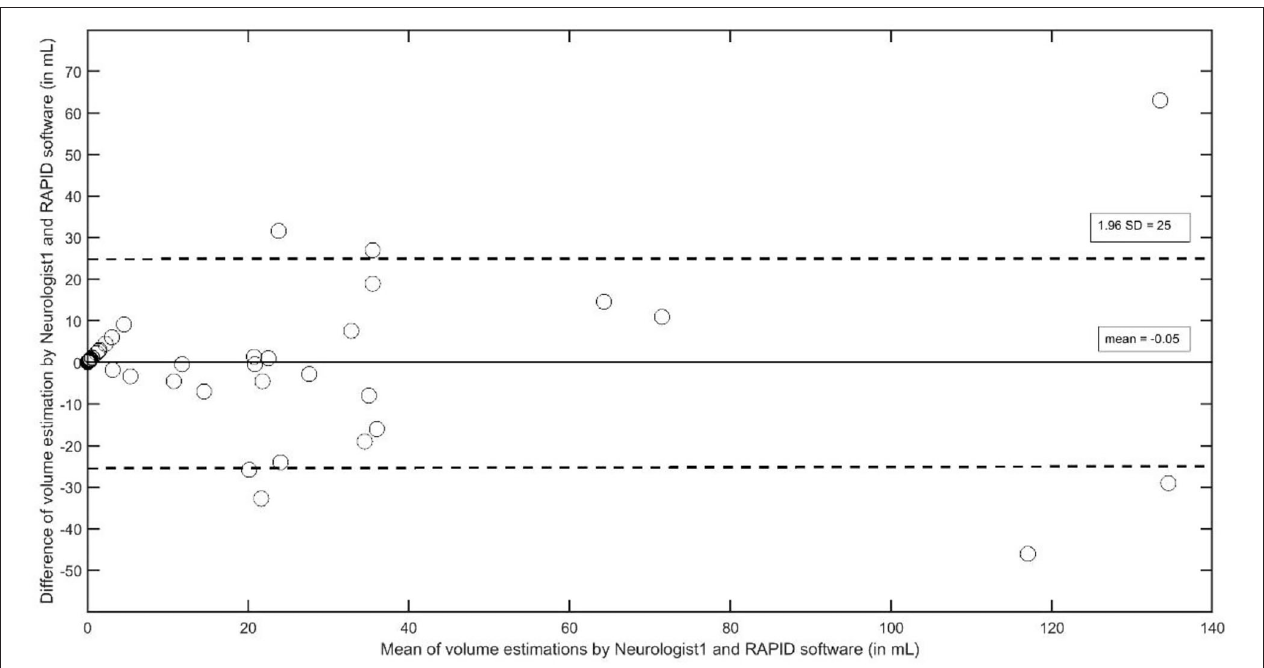
FIGURE 2 | The Bland–Altman plot to analyze interobserver agreement between Neurologist1 and the RAPID software to estimate stroke volumes in supratentorial strokes.